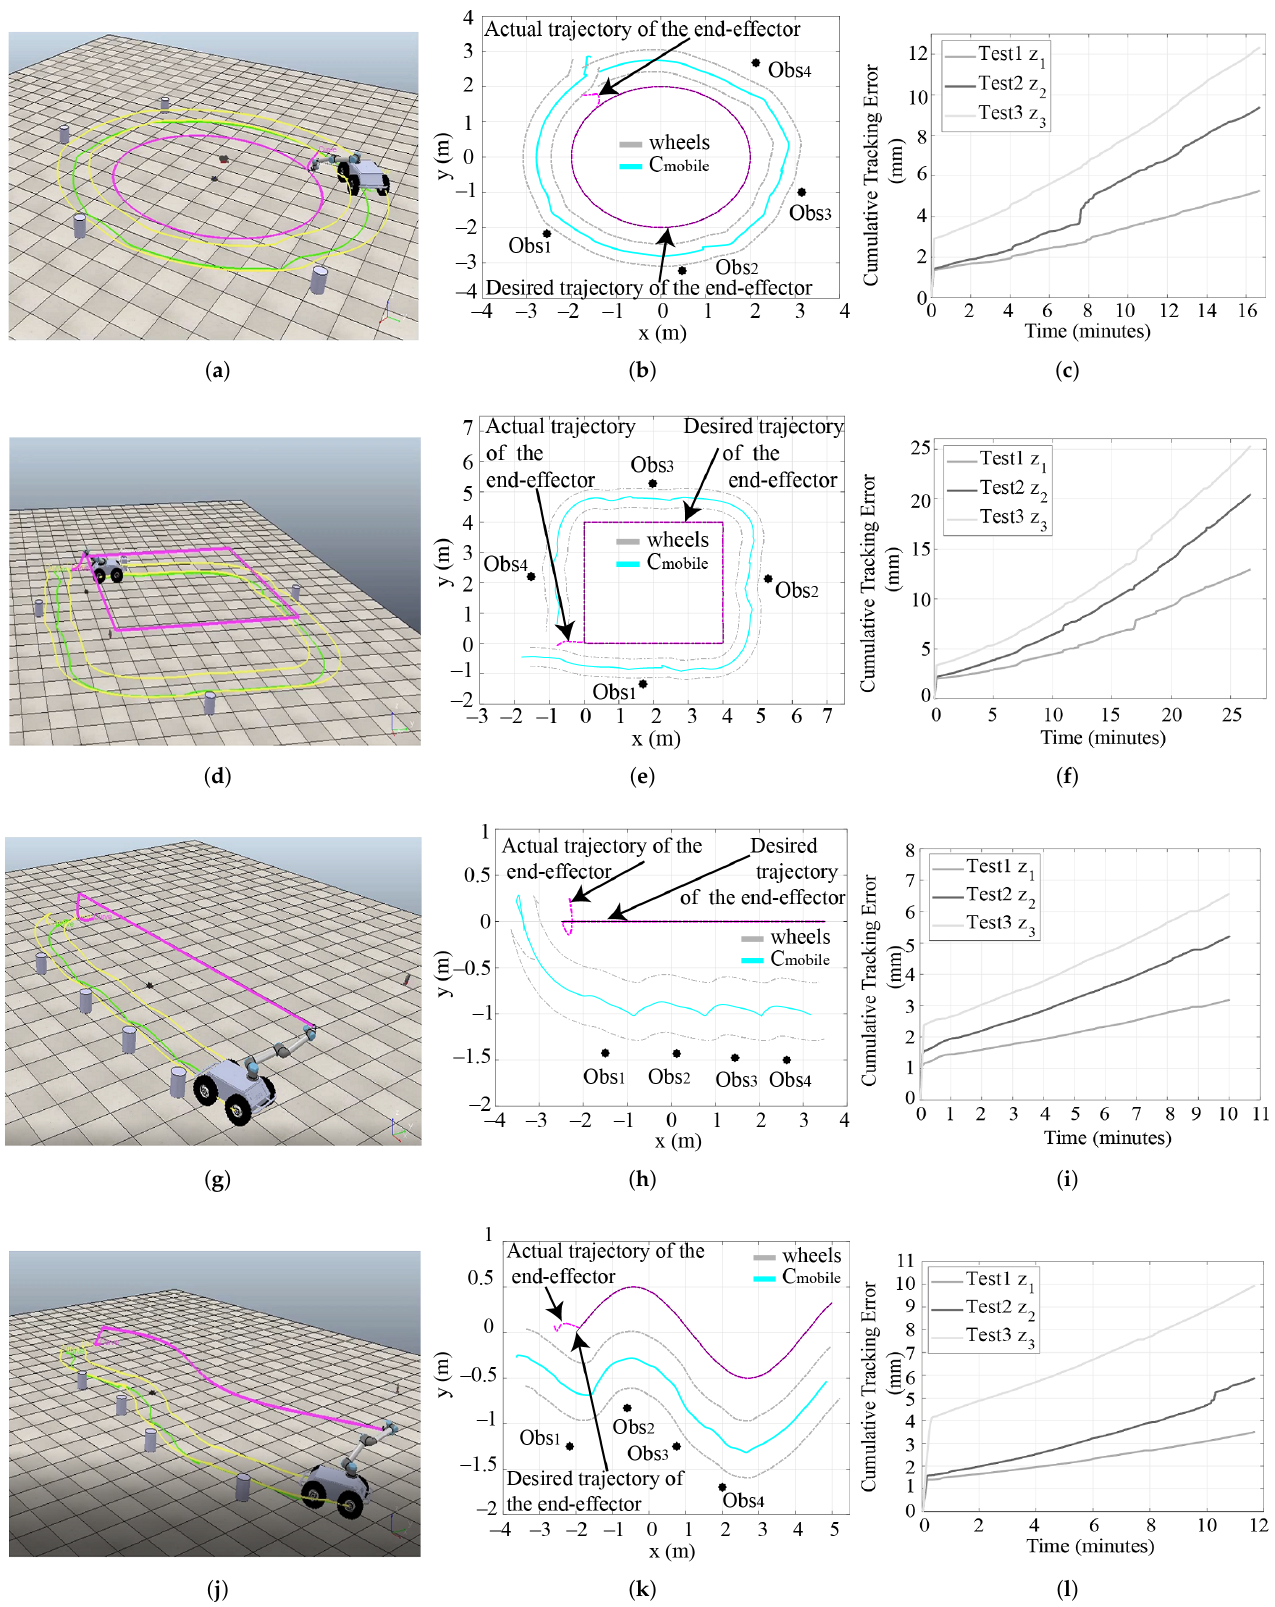
Figure 8. The trajectory reproduced in CoppeliaSim is shown in the first column ( a , d , g , j ). The second column ( b , e , h , k ) shows the four proposed printing profiles. The third column ( c , f , i , l ) shows the cumulative printing errors for three different